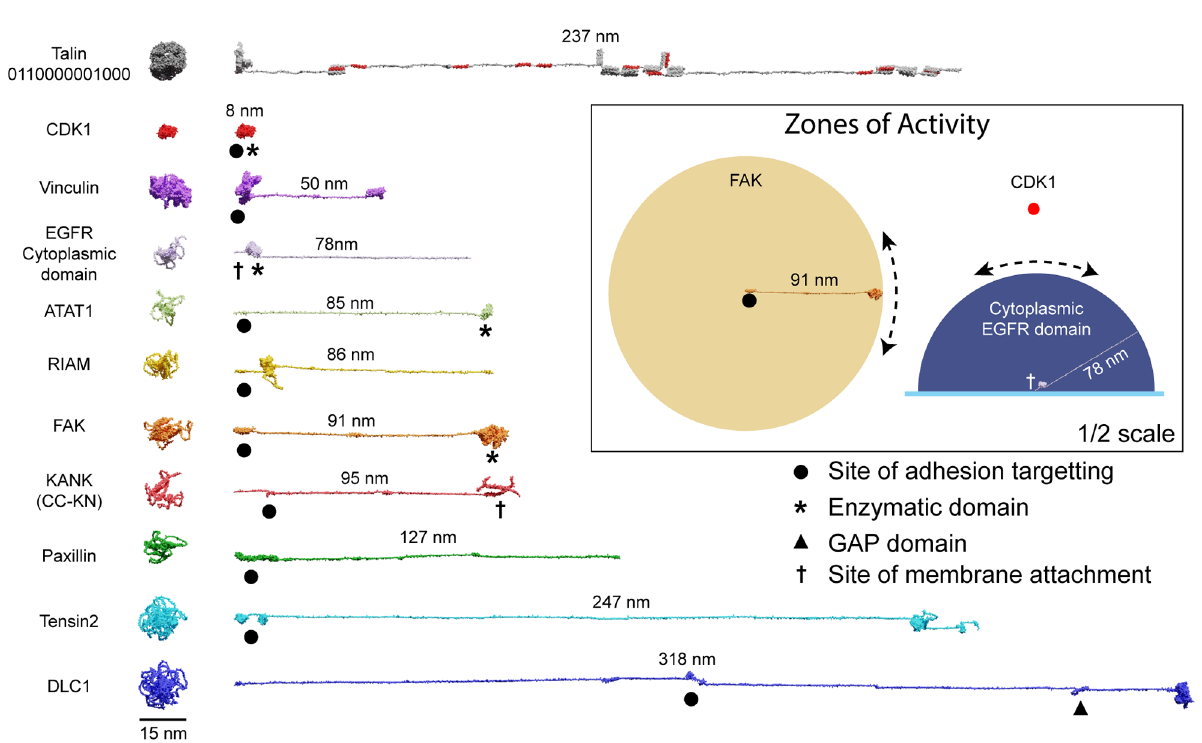
FIGURE5 Zones of activity of MeshCODE interacting proteins are dictated by their unstructured linker regions. AlphaFold models of a subset of the 250 components of IACs drawn to scale. The compact AlphaFold model (left) and extended version (right) are shown for each to illustrate the length of these proteins. Talin is included as a scale bar. The length of the unstructured region defines the radius of the sphere of activity of that protein; when attached to the MeshCODE it can reach molecules within that sphere. Membrane-tethered enzymes have a hemisphere zone of activity, Epidermal Growth Factor Receptor (EGFR) is shown as an example of a membrane-tethered receptor tyrosine kinase (only the cytoplasmic region is shown). Enzymatic domains are marked by * and the GTPase-activating protein (GAP) domain by a triangle. Focal adhesion targeting regions are shown by a dot and membrane attachment sites by a cross. For KANK only the region from the membrane-targeting coiled coil to the talin binding site at the N-terminus is shown (residues 1–517). Inset : Zones of activity of three MeshCODE interacting enzymes, Focal Adhesion Kinase (FAK), Cyclin Dependent Kinase 1 (CDK1), and the membrane-tethered EGFR. The radius of the sphere is the length of the linker between the anchor point and the enzymatic domain, in the case of FAK this is 91 nm, for CDK1, the enzymatic domain binds directly to talin so the sphere is much tighter. The EGFR hemisphere has radius 78 nm. The location of the sphere in 3D space is dictated by where the molecule is anchored, if the anchor point is to the membrane it will be relatively constant, but if it engages talin either directly or indirectly, its location will change dictated by the switch patterns as shown in Figure 4 . For membrane tethered enzymes the position in z- will be constant. The inset is shown at half scale compared to the rest of the